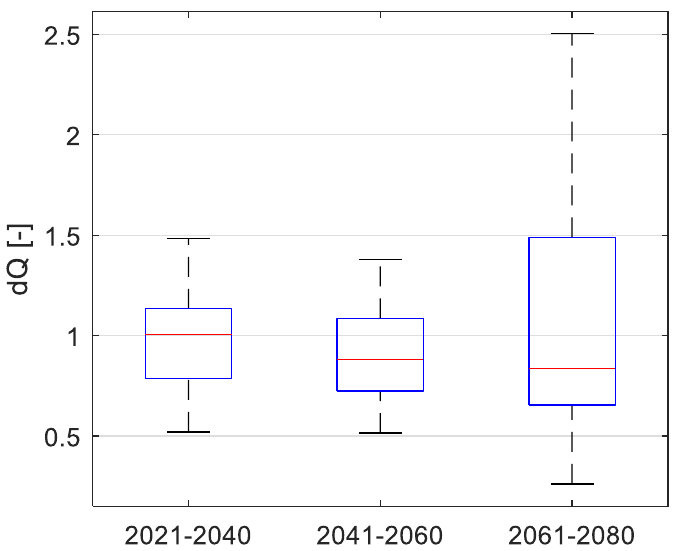
Figure 6. Boxplots of change factors of average annual flows for individual time horizons. Central red line indicates the median, and the bottom and top edges of the blue box indicate the 25th and 75th percentiles, respectively. The whiskers extend is specified as 1.5 times the interquartile range.